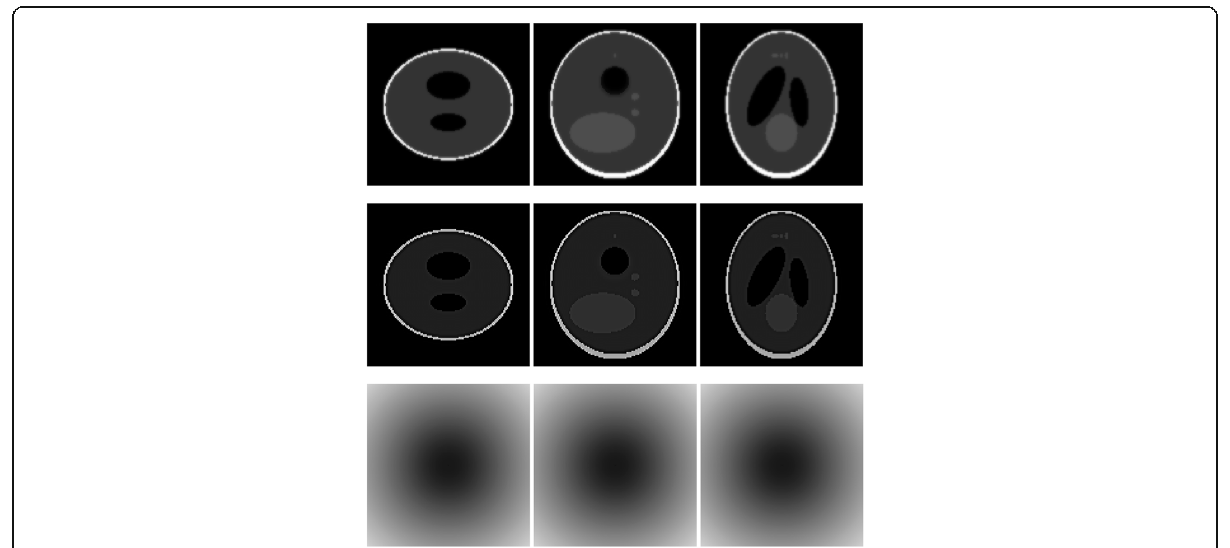
Fig. 12 Image reconstruction using proposed algorithm for the case of ψ = π /2 and σ = 1. This is the ‘ 4 π ’ case. Row 1 : TOF backprojection. Row 2 : Final reconstruction. Row 3 : Tomographic filter H . Three central orthogonal cuts are shown for each row